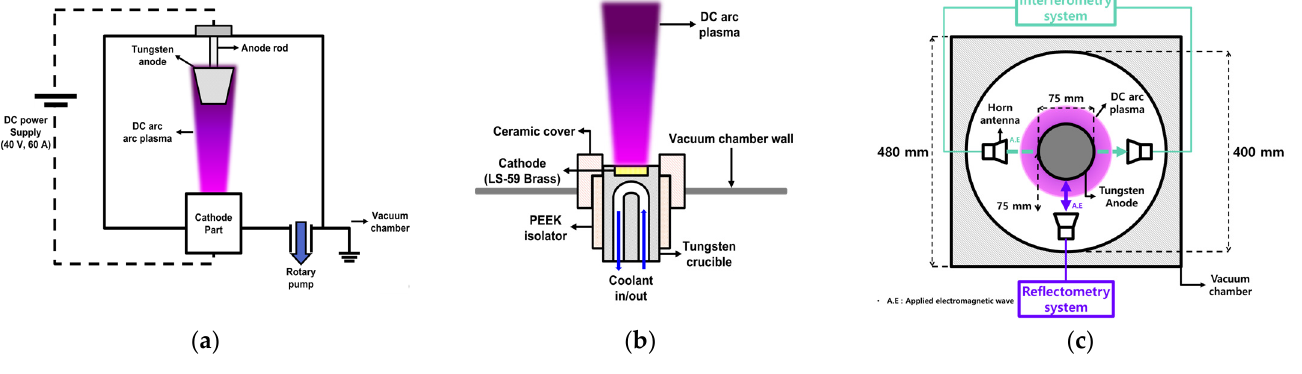
Figure 1. Schematic of the configuration of the hot refractory anode vacuum arc (HRAVA) plasma system; ( a ) Schematic of overall configuration, ( b ) Schematic of cathode part, ( c ) Schematic of HRAVA plasma system from top ‐ view.